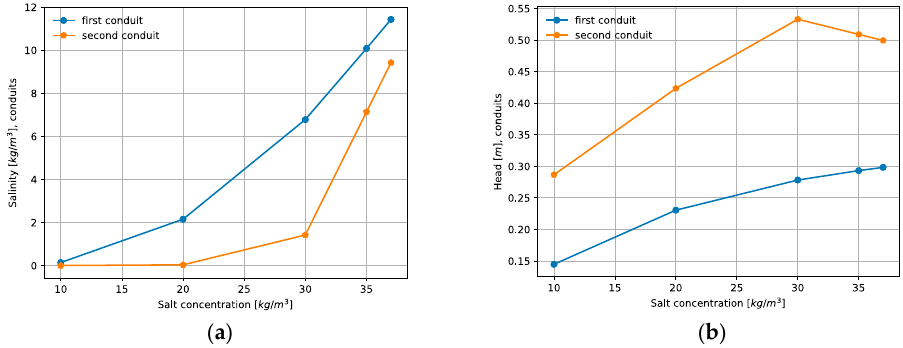
Figure 9. Correlation coefficient matrix for all four parameters in different locations of the aquifer: conduits, fractured medium near and away conduits.